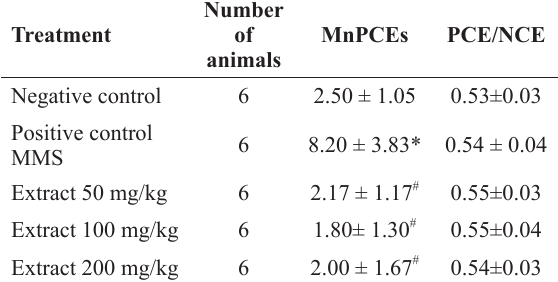
Values obtained using MN tests in bone marrow at different doses of Hibiscus acetosella .